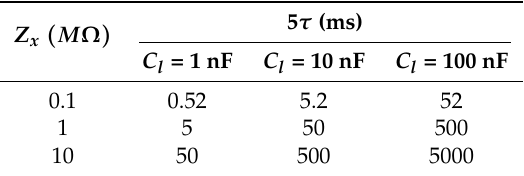
Table 2. Suitable time intervals in the serial electrical excitation